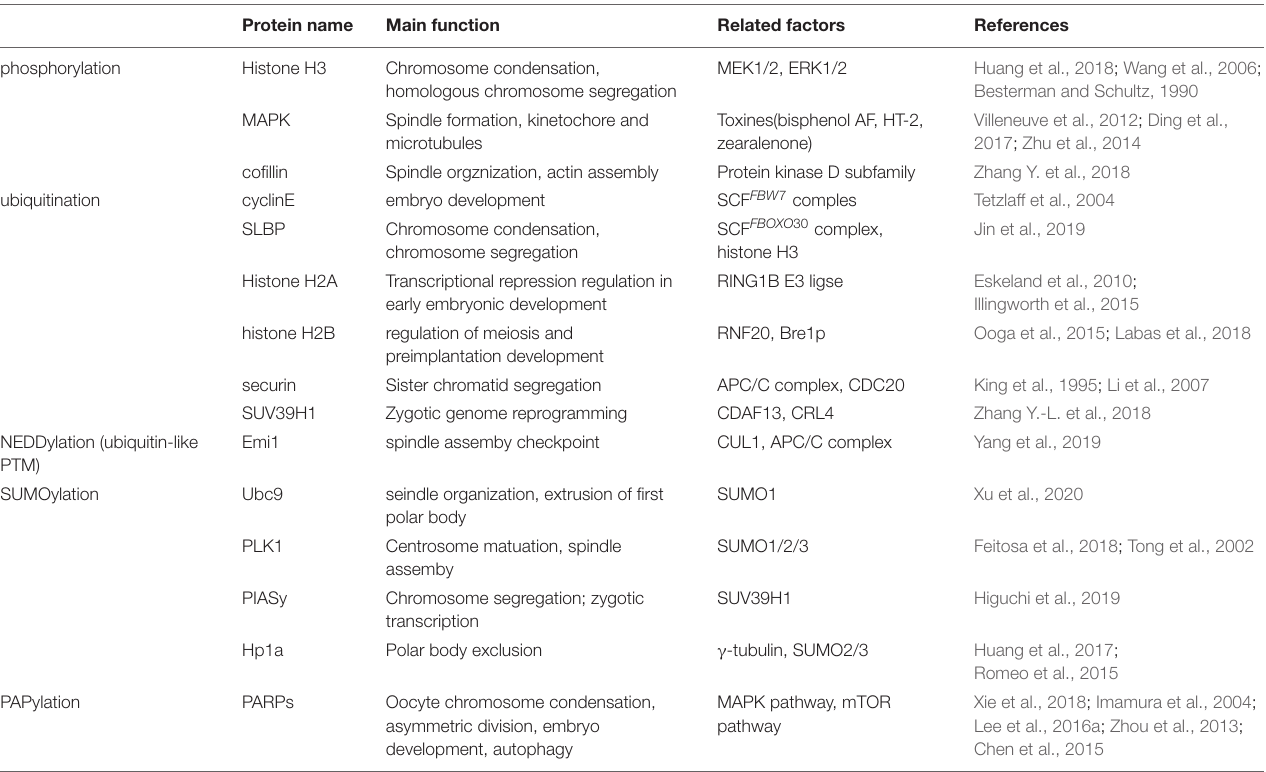
TABLE 1 | Main PTMs of oocyte maturation and early embryo